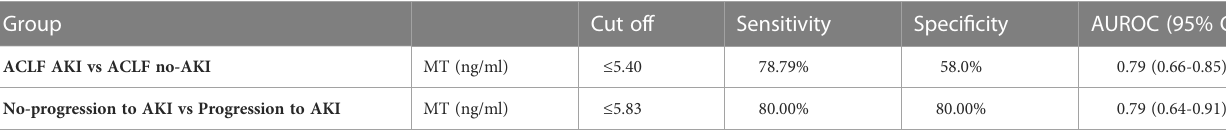
TABLE 6 AUROC analysis results of (a) ACLF AKI vs ACLF no-AKI and, (b) Progression to AKI vs No-progression to AKI. Group